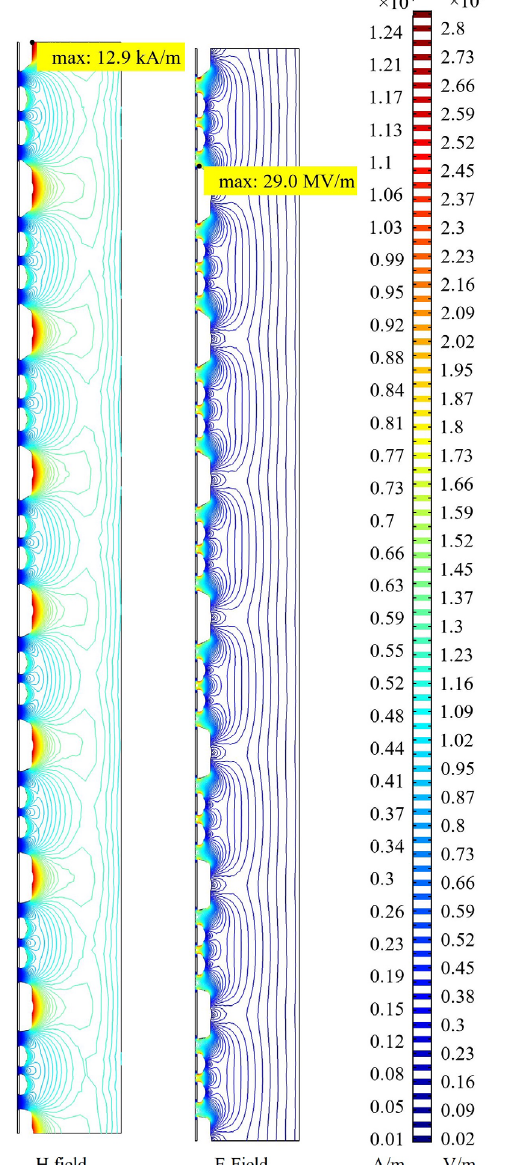
FIG. 13. A cross-sectional view of electric and magnetic field distribution in a QA-DTL cavity at 4 MV = m.